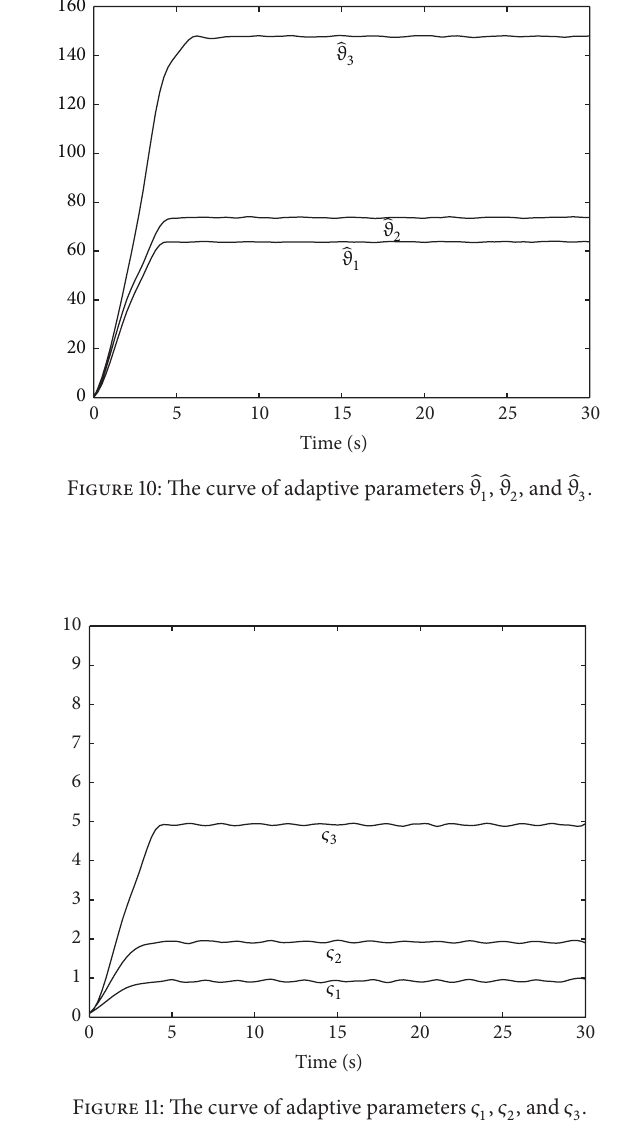
Figure 11: The curve of adaptive parameters 𝜍 1 , 𝜍 2 , and 𝜍 3